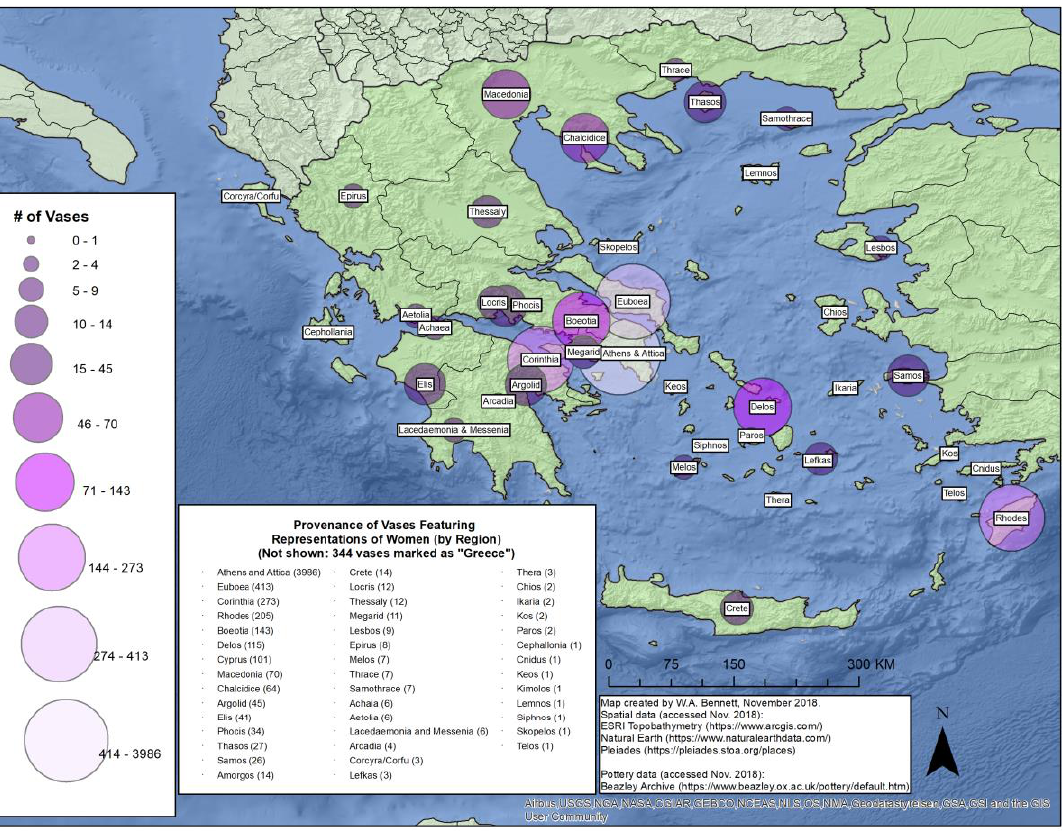
Figure 4. Map showing known provenance of vases with Athenian fabric within Greece in the BAPD dating to the 5th century BCE and including at least one representation of a woman by polis. Credit: Produced by Wesley A. Bennett for the author’s use.